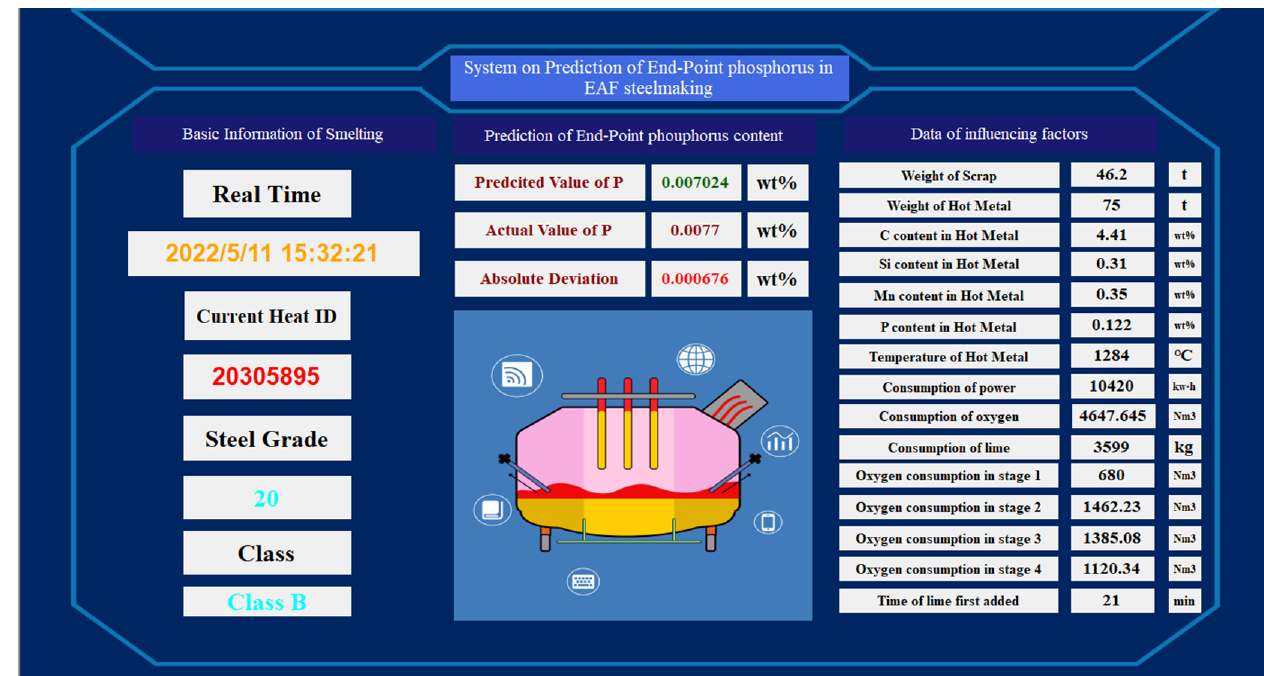
Figure 13. System for the prediction of end-point P content in EAF steelmaking.